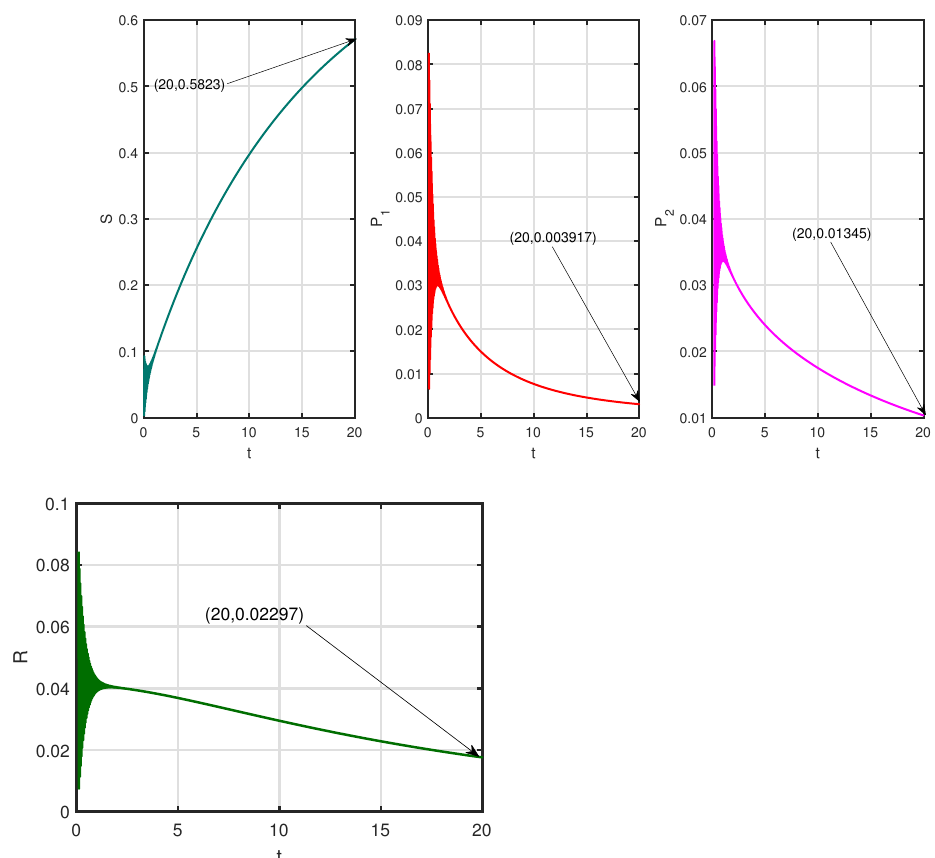
Figure 12. Time series of state variables of system (26) for Table 6 when ε = 0.95 , ω 1 = 1.6, ω 2 = 10.